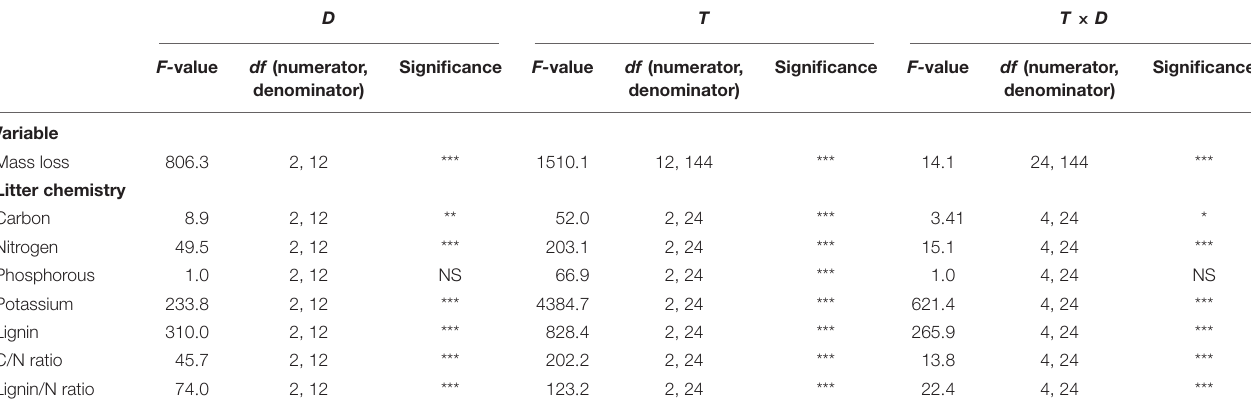
TABLE 1 | Results of the repeated-measurement ANOVAs on the response of variables to the imposed drought treatments ( D ), time of sampling ( T ), and their interaction ( T × D ). D T T × D F- value df (numerator, Significance F- denominator)